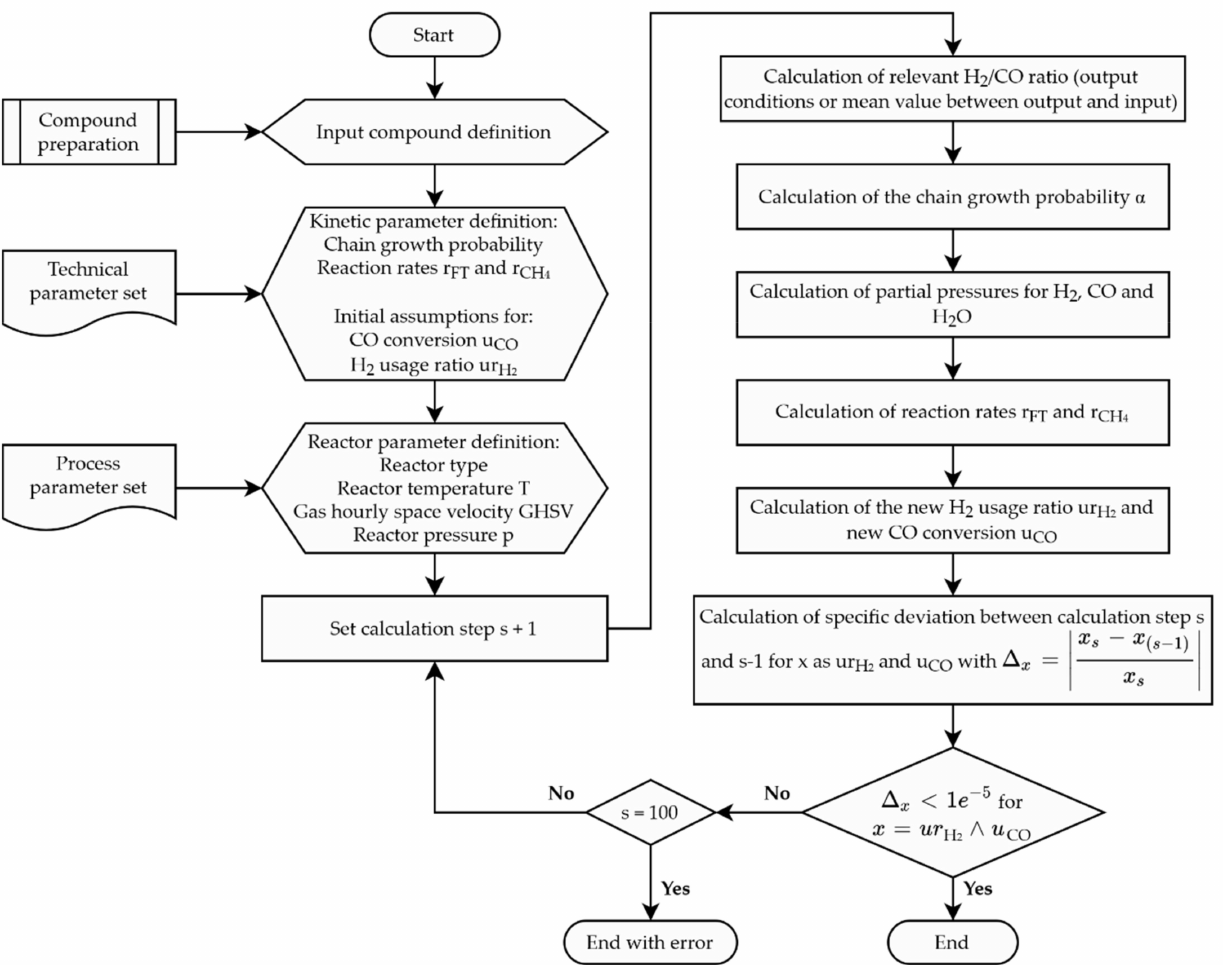
Figure 3. Flow chart of the Fischer–Tropsch (FT) reactor calculation model.